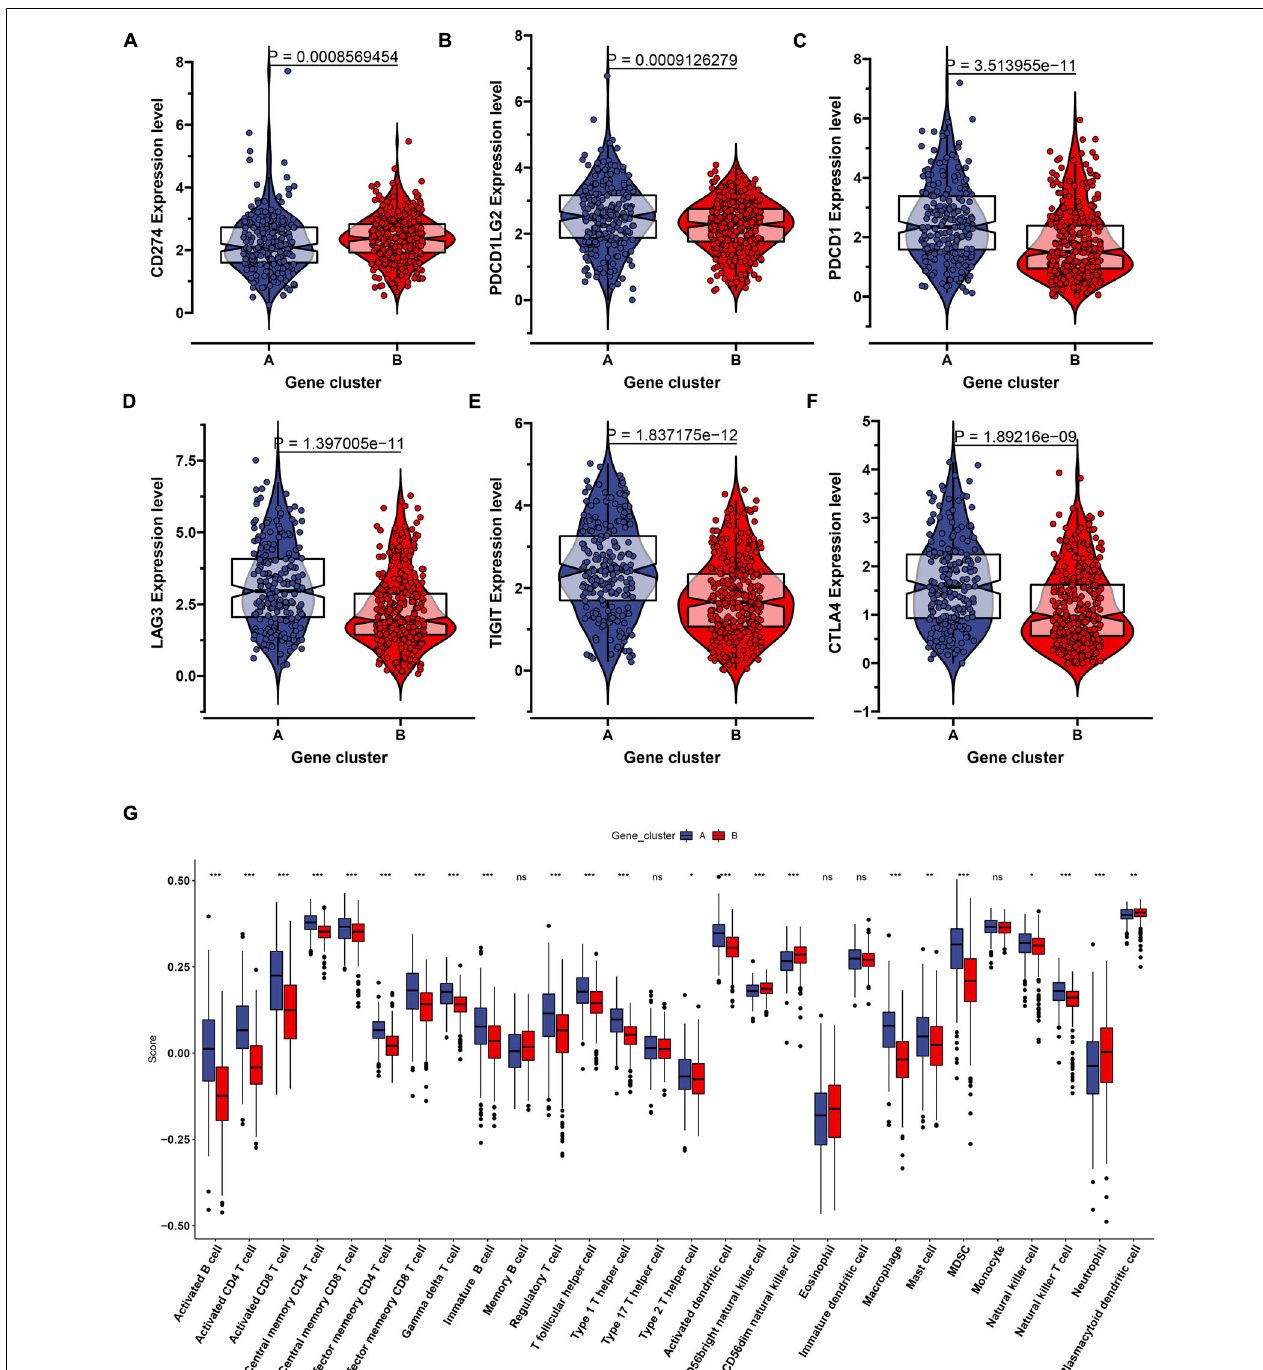
FIGURE 9 | The evaluation of the immune checkpoint and immune cell infiltration in the two genomic clusters. The expression level of six immune checkpoint including CD274 (A) , PDCD1LG2 (B) , PDCD1 (C) , LAG3 (D) , TIGIT (E) , CTLA4 (F) were showed in the two genomic clusters. (G) Twenty eight immune cells infiltration level were compared in the two genomic clusters. ns: not significant, * P < 0.05, ** P < 0.01, *** P <